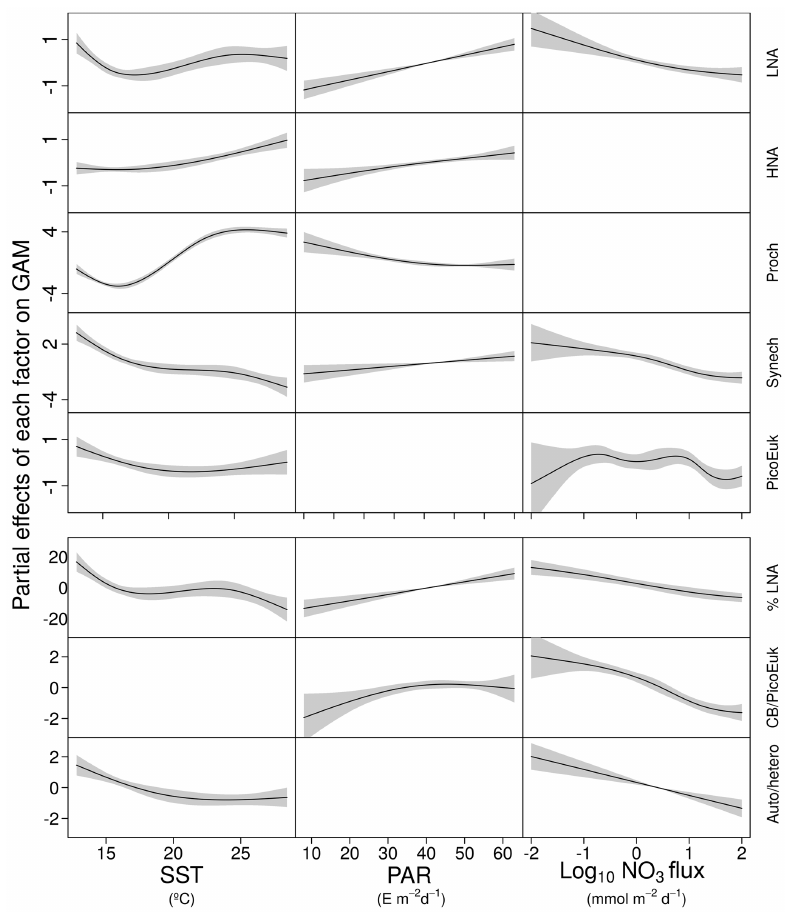
Figure 4. GAM-predicted effects of the response variables (biomass and contribution of picoplankton subgroups) as a smooth function of sea surface temperature (SST), photosynthetically active radiation (PAR), and nitrate flux (NO 3 flux). All terms were centered at zero. Significant linear relationships are indicated as solid ( p value < 0 . 01) black lines. Shaded regions represent the 95% confidence intervals of the smooth spline functions. Intercept values were 4.6 (LNA), 5.1 (HNA), 2.1 ( Prochlorococcus ), 3.6 ( Synechococcus ), 3.7 (picoeukary- otes), 36.4 (contribution of LNA to heterotrophic picoplankton, %LNA), 1.4 (cyanobacteria-to-picoeukaryote ratio, CB/PicoEuk), and − 0.1 (autotrophic-to-heterotrophic biomass ratio, Auto /